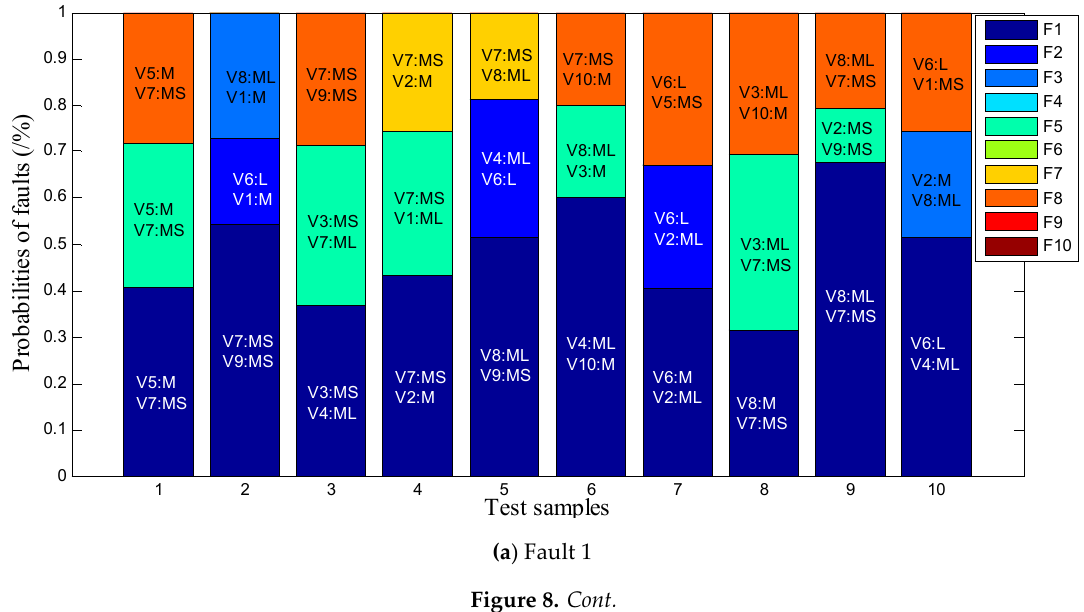
Figure 8. Figure 8. Cont.